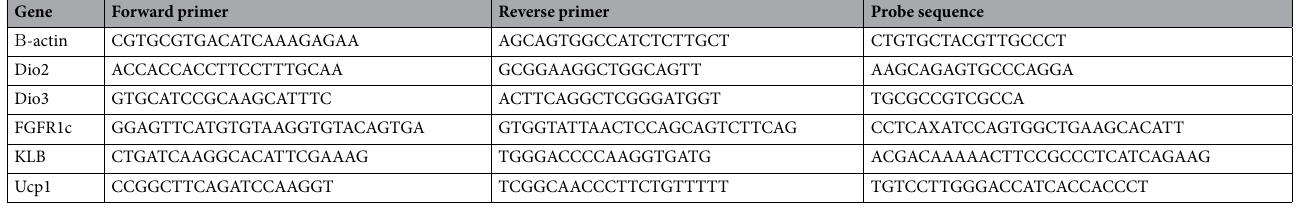
Table 1. Primers and